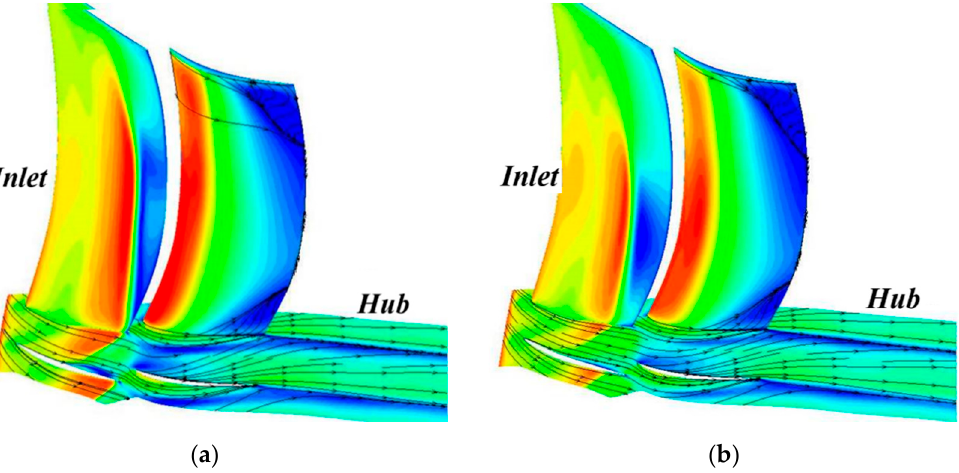
Figure 24. FB surface isentropic Mach number at 80% design speed at the CO point. ( a ) 10% blade height ; ( b ) 50% blade height ; ( c ) 90% blade height.